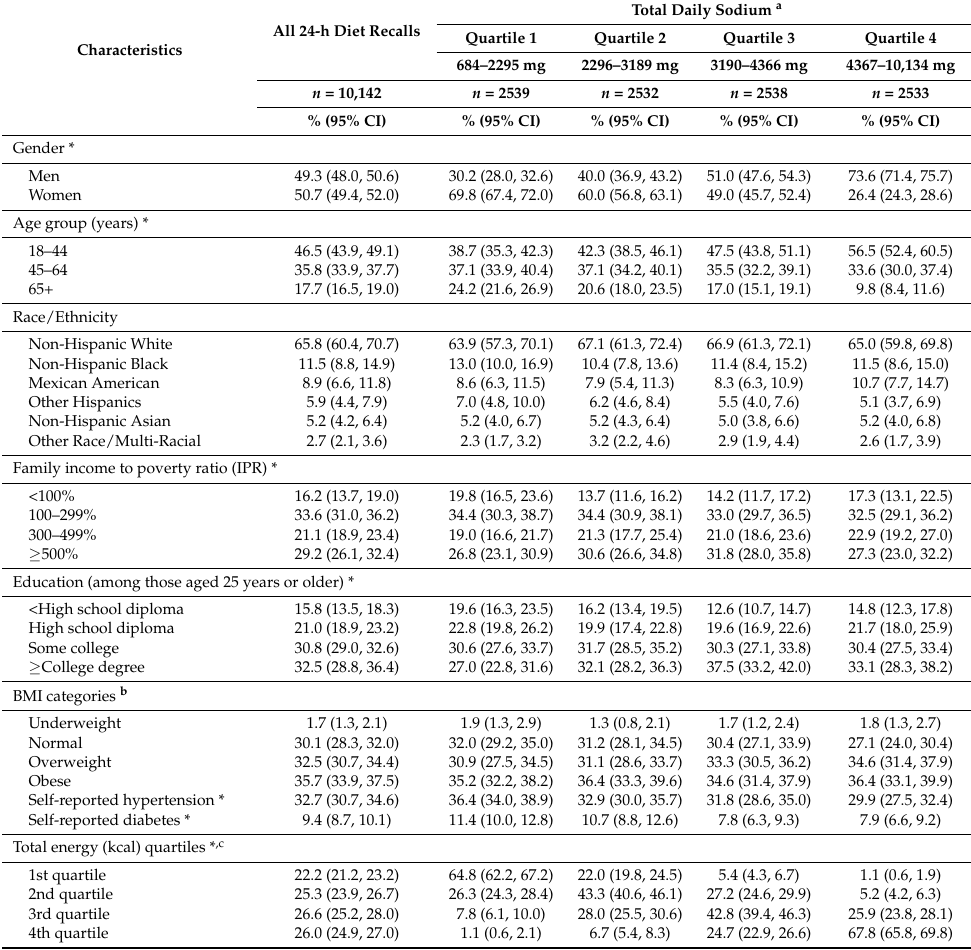
Table 2. Characteristics of one-day dietary measures by dietary sodium quartiles for US adults aged ≥ 18 years—National Health and Nutrition Examination Survey, 2011–2014.